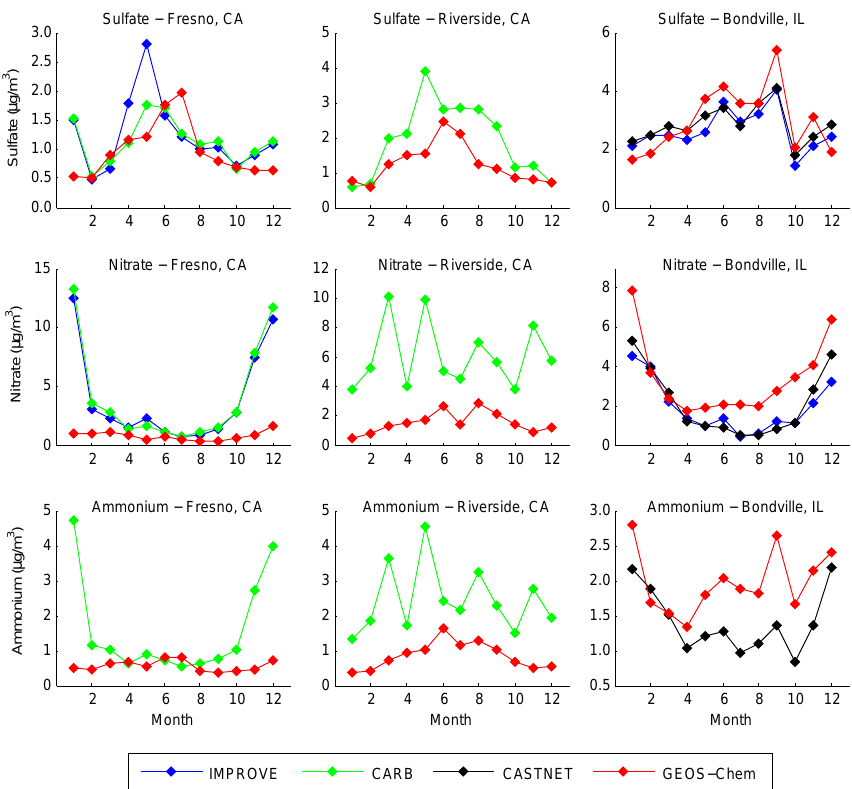
Fig. 7. 2009 monthly mean predicted and measured aerosol sulfate, nitrate, and ammonium concentrations at selected sites.